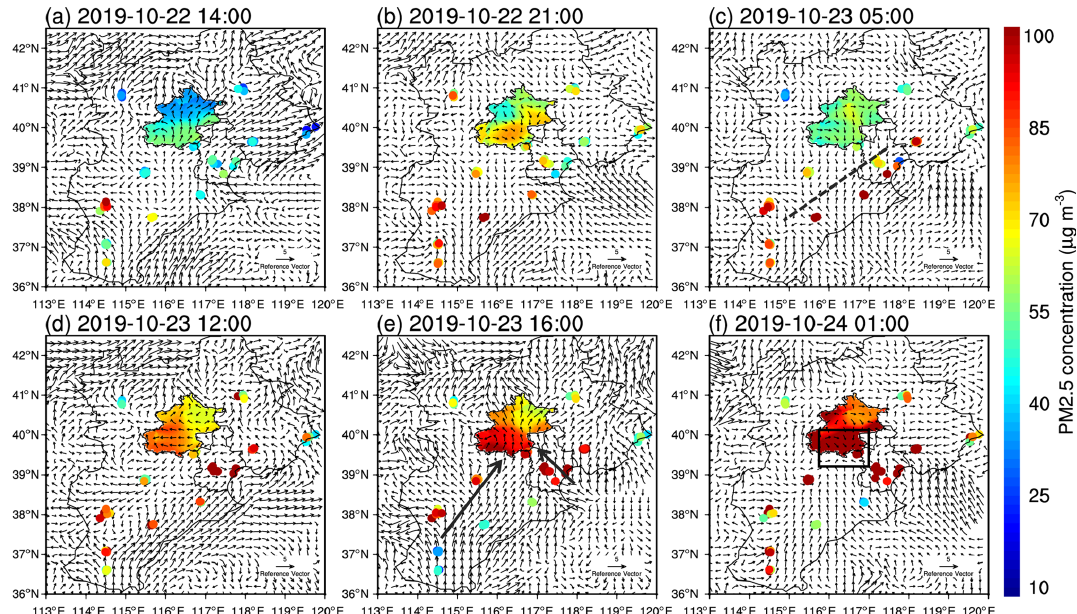
Figure 5. The surface winds (vectors; units: ms − 1 ) in the NCP and PM 2 . 5 concentration at the Beijing (shaded; units: 10 − 1 µgm − 3 ), Hebei, and Tianjin monitoring sites (scatter; units: 10 − 1 µgm − 3 ) of different times (local time) for type C. The dashed line represents the convergence belt. The arrow lines represent the pollutant transport channels. The rectangle represents the convergent